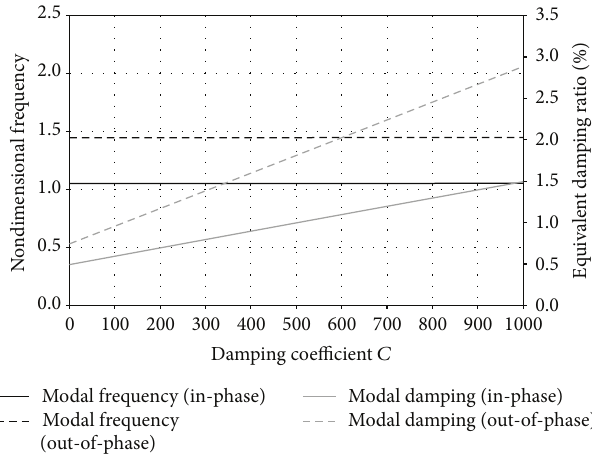
Figure 7: Effect of cross-tie damping coefficient 𝐶 on modal frequency and modal damping ratio of the lowest in-phase and out- of-phase global modes of an asymmetric DMT cable